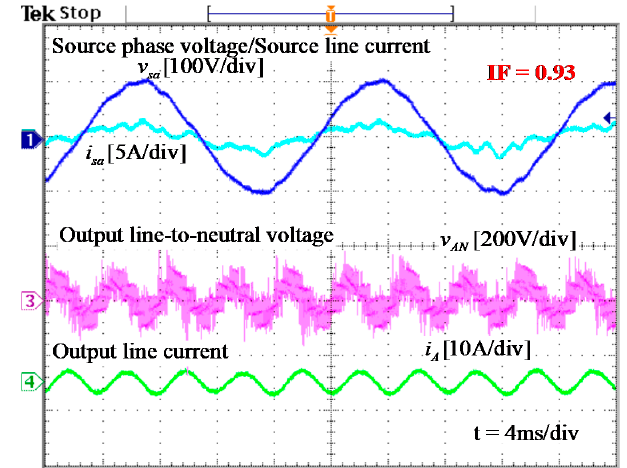
Figure 15. Source phase voltage/source current, output line-to-neutral voltage, and output line current at f o = 200 Hz ( Q ≈ 0.375 ) , q = 0.6 with maximum compensated angle.